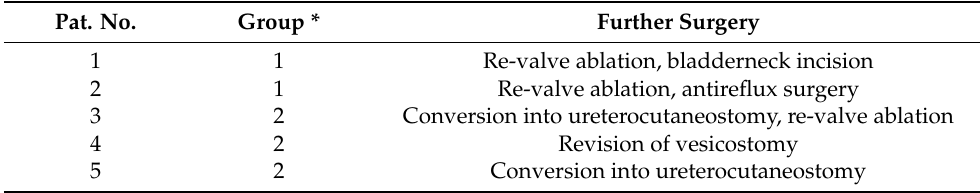
Table 5. Case-related further surgery. Pat. No. Group * Further Surgery 1 1 Re-valve ablation, bladderneck incision 1 Re-valve ablation, antireflux